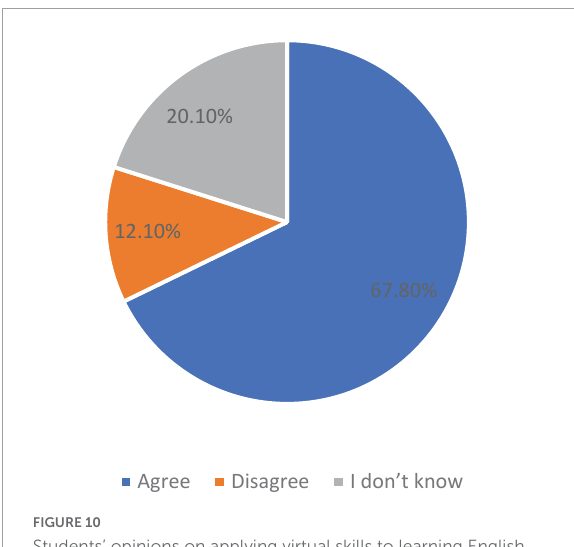
FIGURE9 Students’ opinions on continuing virtual learning after the COVID-19 pandemic.